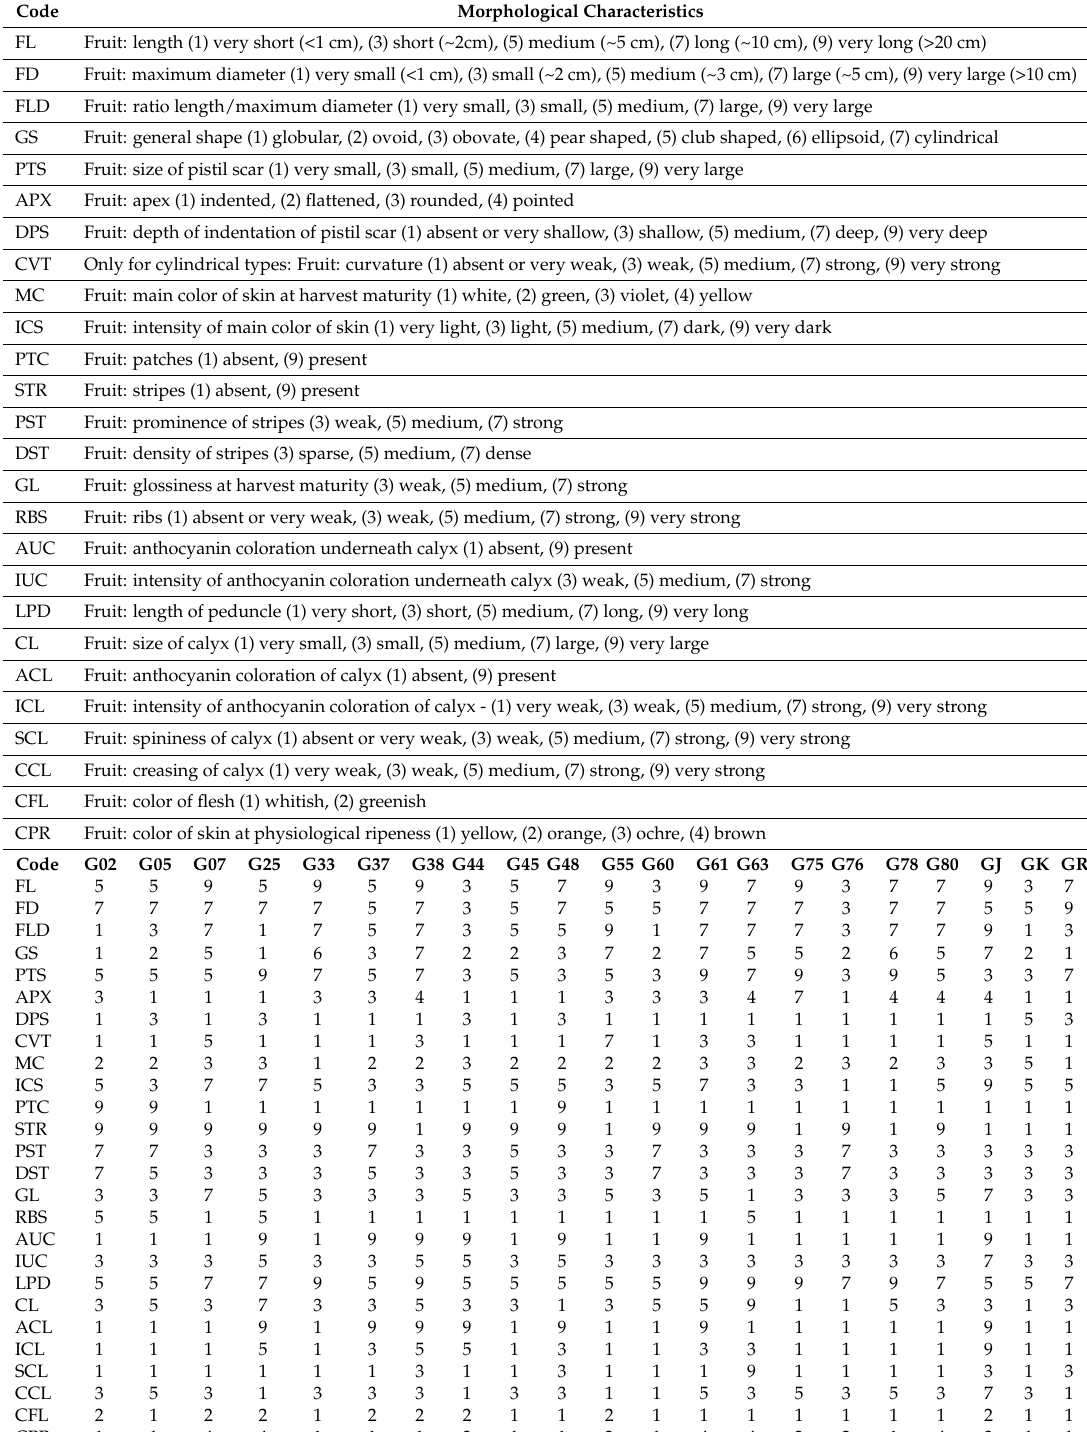
Table 3. Description of fruit morphologies for 21 eggplant accessions based on UPOV. Code Morphological